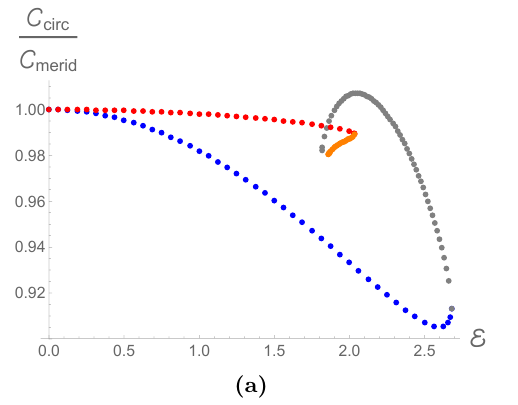
Figure 11. Isometric embeddings of black hole horizons at (cid:12)xed T = 1 =(cid:25) . The curves for the L1, L2, S1, and S2 black holes are blue, gray, red, and orange, respectively.